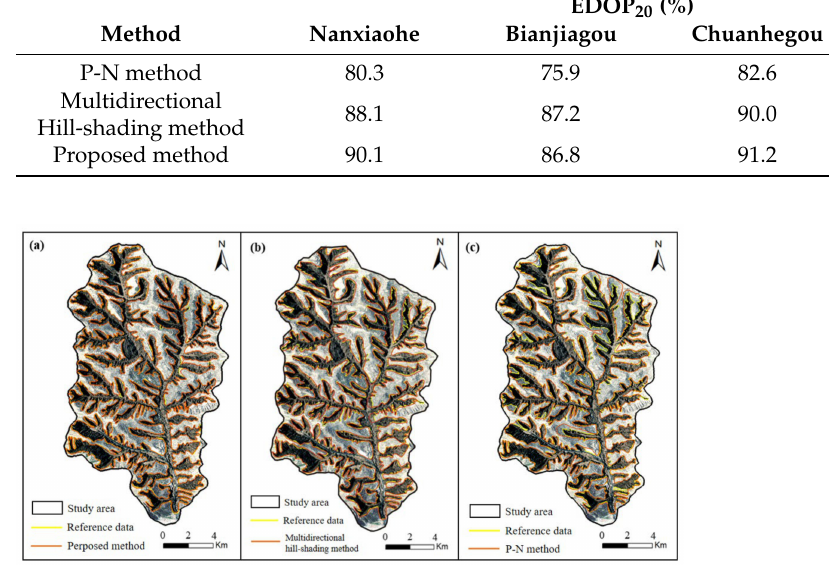
Figure 16. Extraction results of the shoulder line with the three methods: ( a ) proposed method; ( b ) multidirectional hill-shading method; ( c ) P-N